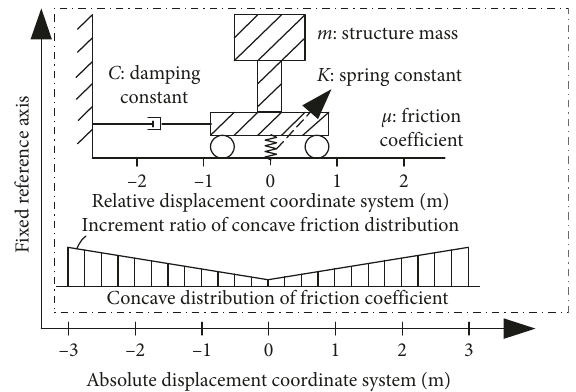
Figure 1: A vertical spring-viscous damper-concave friction iso- lation system.